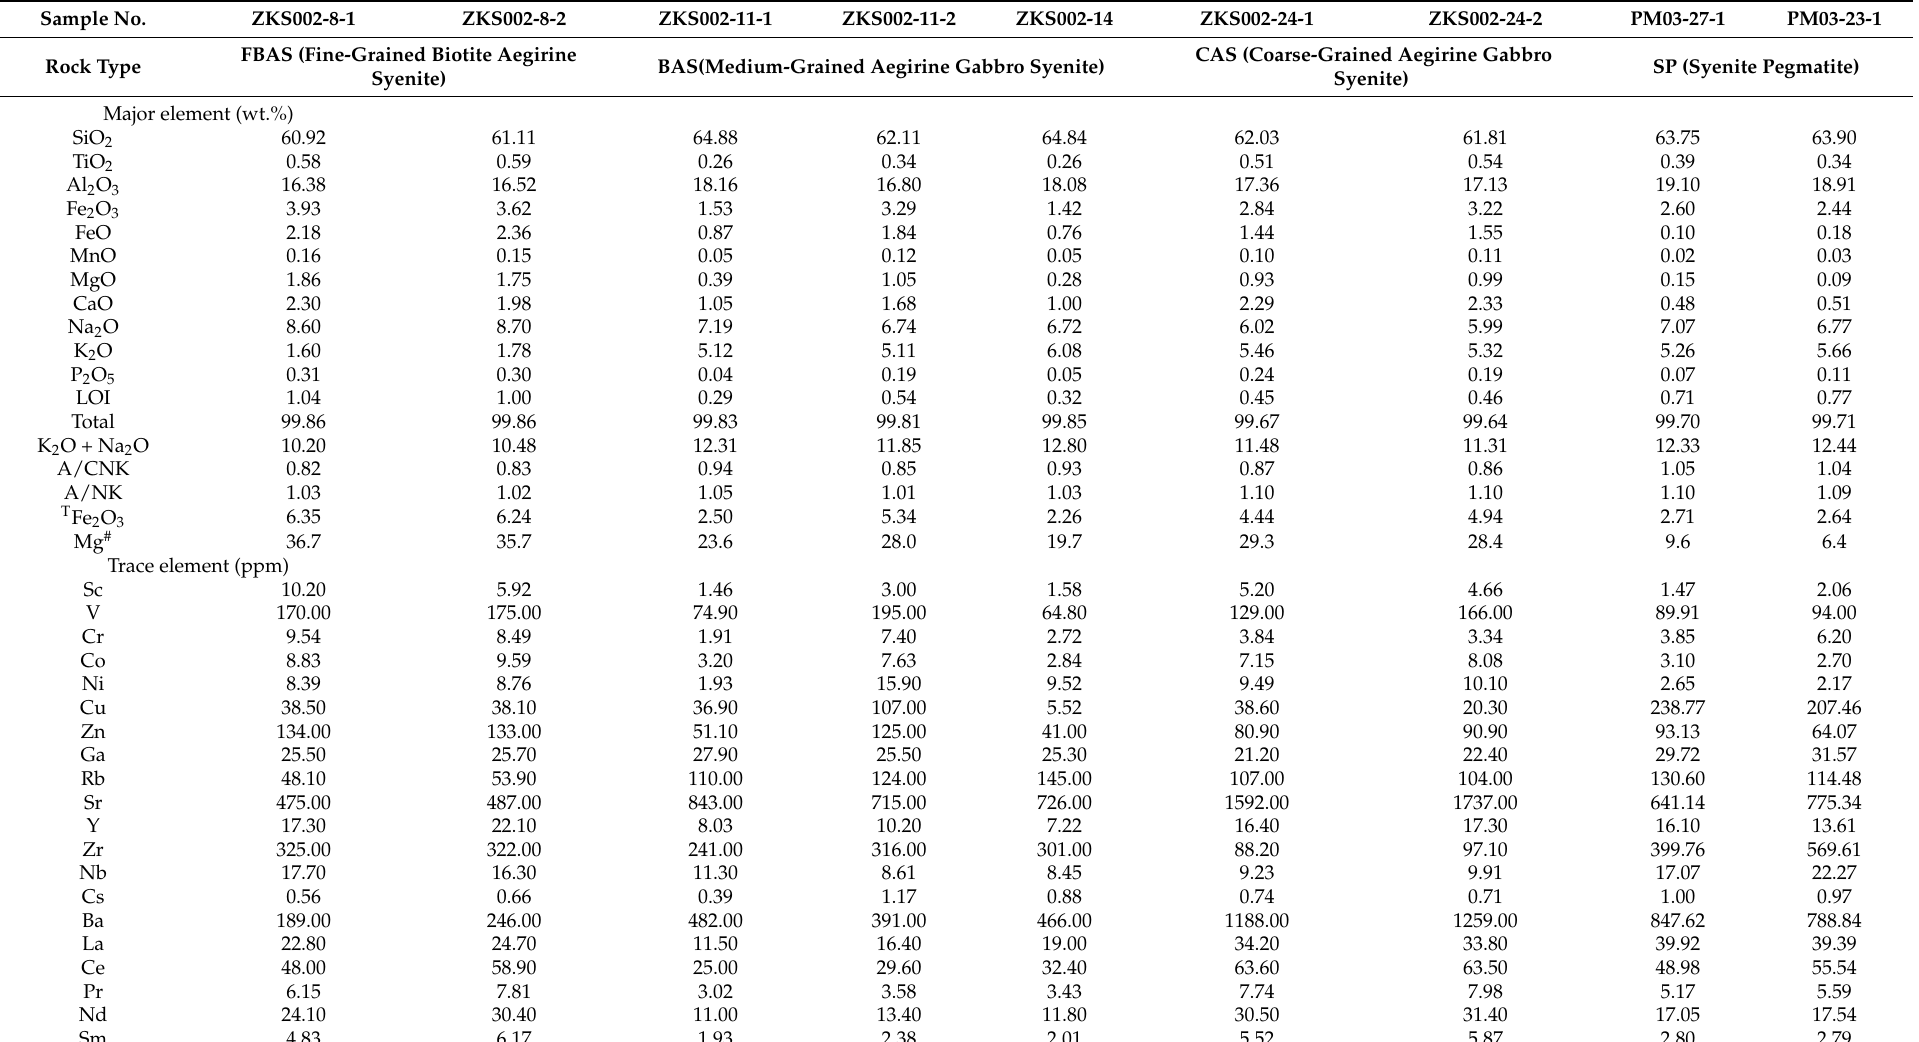
Table 2. Major (wt.%) and trace (ppm) elements for the Hongshan